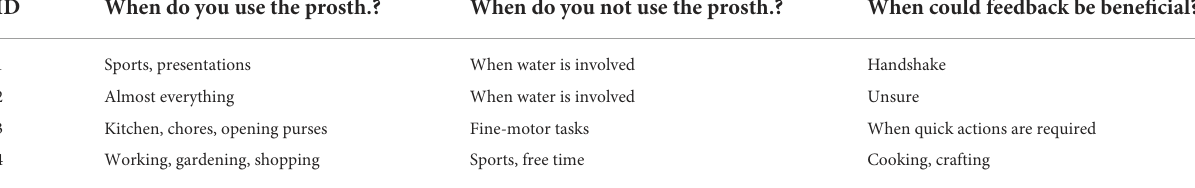
TABLE 2 The participants’ answers to the pre-study questionnaire.